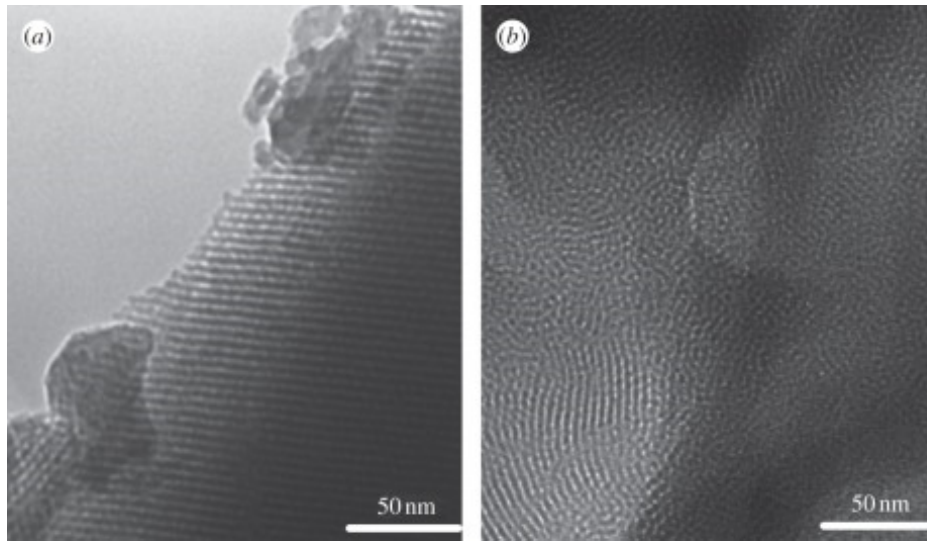
Figure 7. Transmission electron microscopy images of ( a ) P123-templated MBG and ( b ) cetyltrimethylammonium bromide (CTAB)-templated MBG